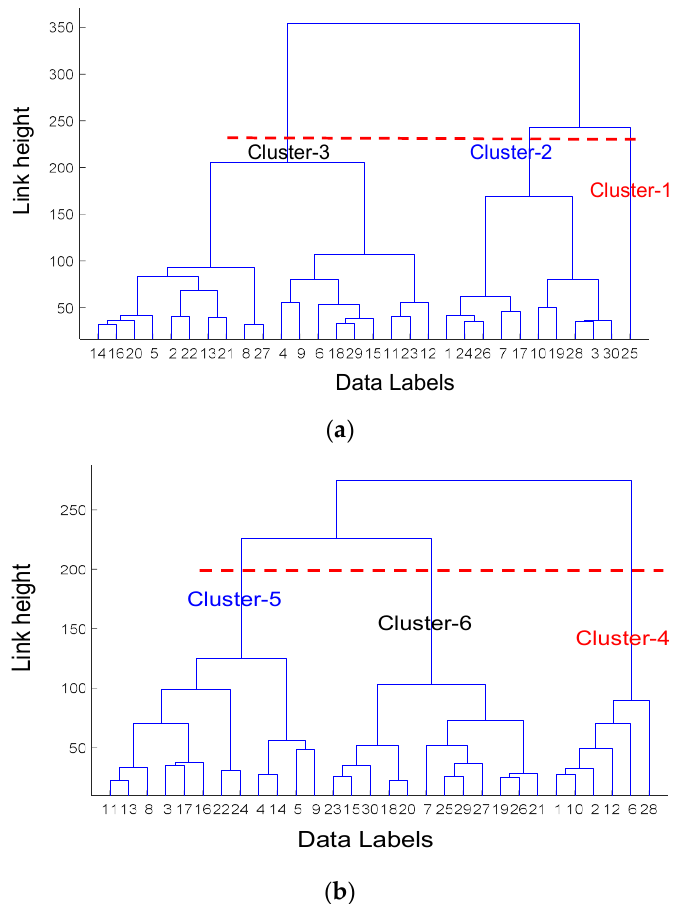
Figure 7. Clustering dendrograms. ( a ) Confined specimen; ( b ) Unconfined specimen.